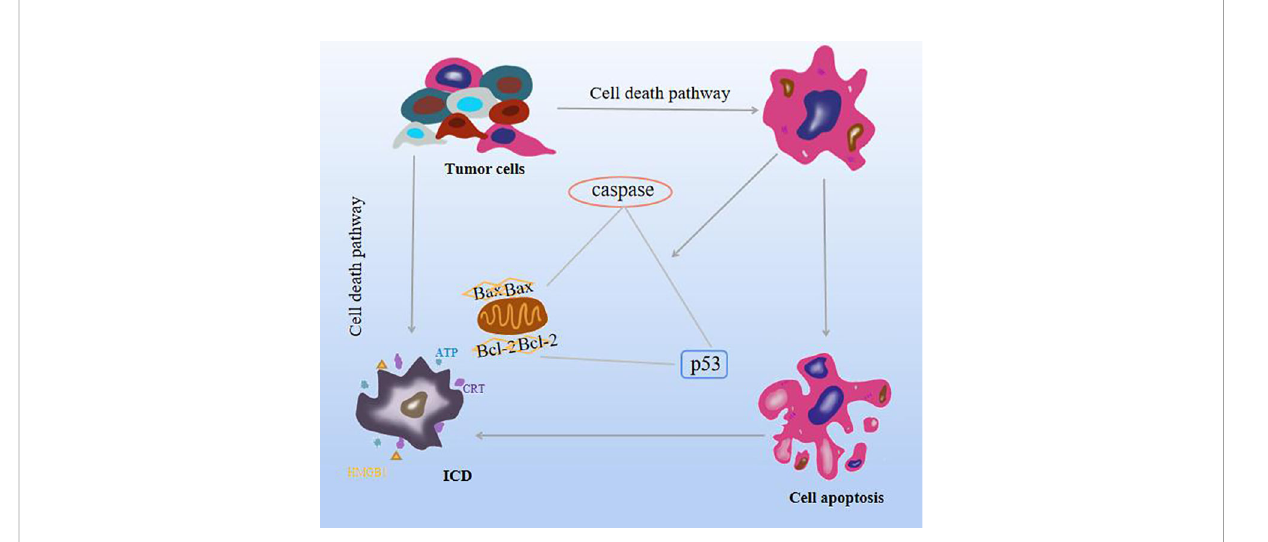
FIGURE 2 Effects of natural compounds on apoptosis and ICD